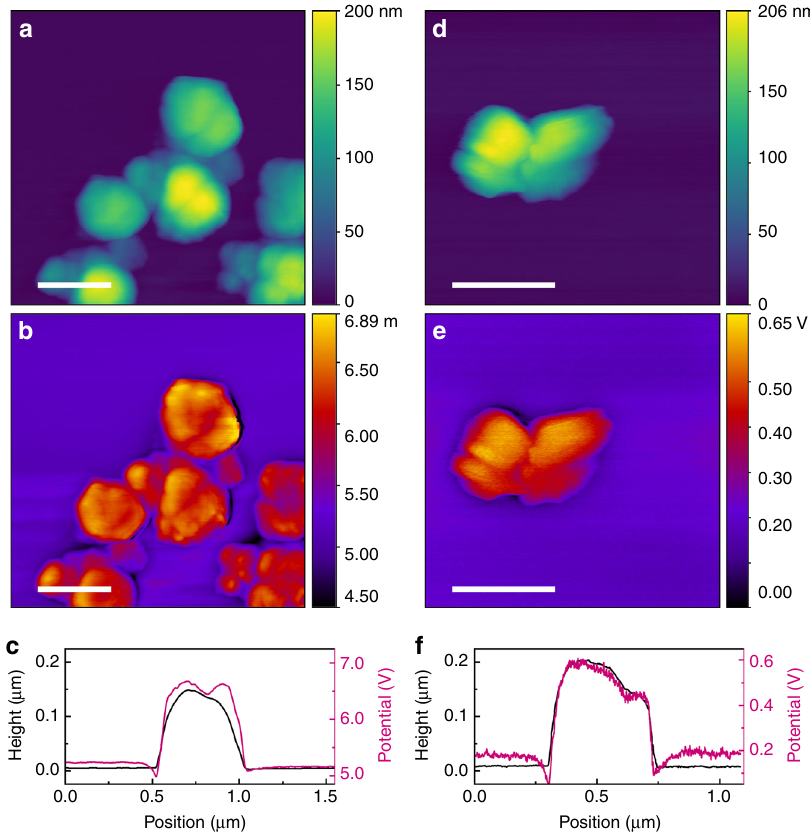
Fig. 3 Electronic properties of the 1T ’ and 2H WSe 2 nanosheets. a Tapping mode atomic force microscopic (AFM) image, b Kelvin probe force microscopic (KPFM) image and ( c ) height pro fi le (black) and the corresponding contact potential difference variation (purple) of the as-produced 1T ’ WSe 2 nano fl owers assembled on a p-doped Si wafer. d Tapping mode AFM image, e KPFM image and f the line scans of the annealed 2H WSe 2 nano fl owers. Scale bars: 500